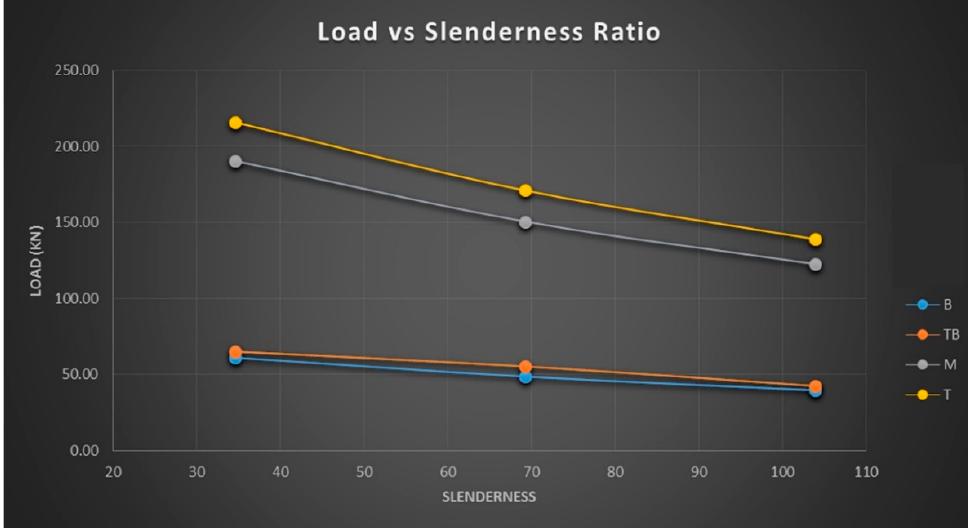
Figure 9. Load capacity vs. slenderness ratio.